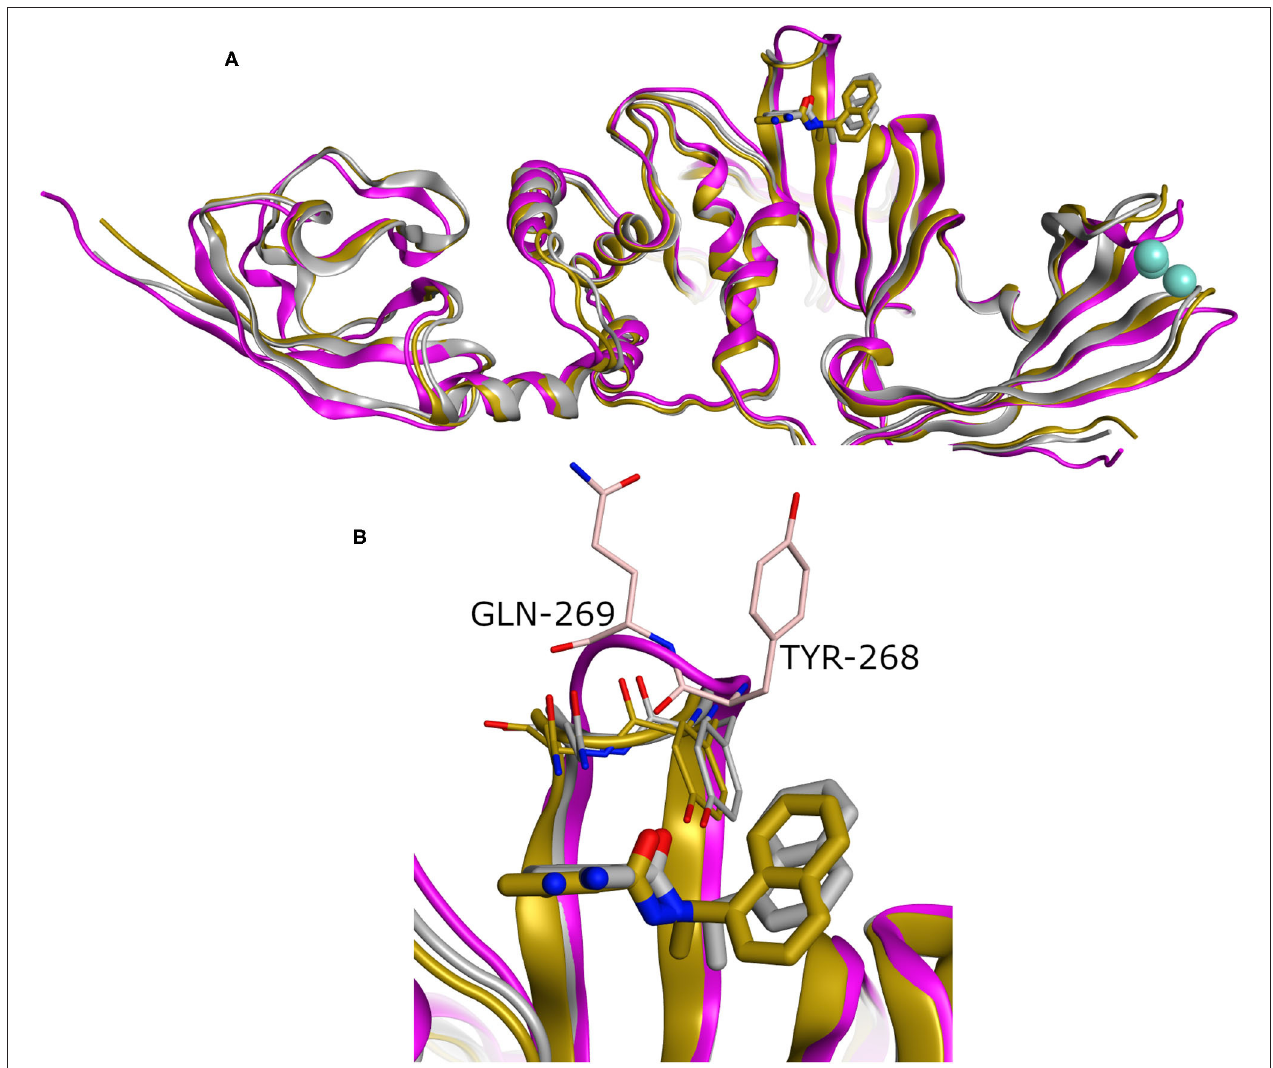
FIGURE 5 | (A) Superposition of three SARS-CoV2 PLpro structures involving the homology model, the X-ray structure complexed with peptide-like inhibitor (PDB ID: 6WUU), and the recently introduced X-ray structure complexed with TTT (PDB ID: 7JRN) as gray, purple, and gold cartoon representation, respectively. (B) The enlarged part of the binding site showing comparable conformations of the key Tyr268 and Gln269 residues and the bound ligand ( TTT) for both the homology and the X-ray structure (PDB ID: 7JRN). The co-crystal peptide-like ligand (PDB ID: 6WUU) was omitted for